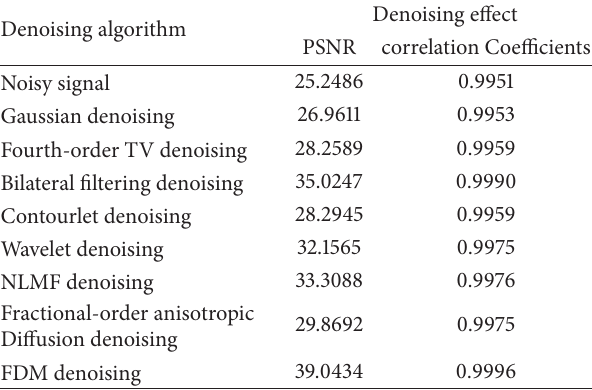
Table 1: Denoising effect for composite one-dimensional signal that combined rectangle wave, sine wave, and sawtooth